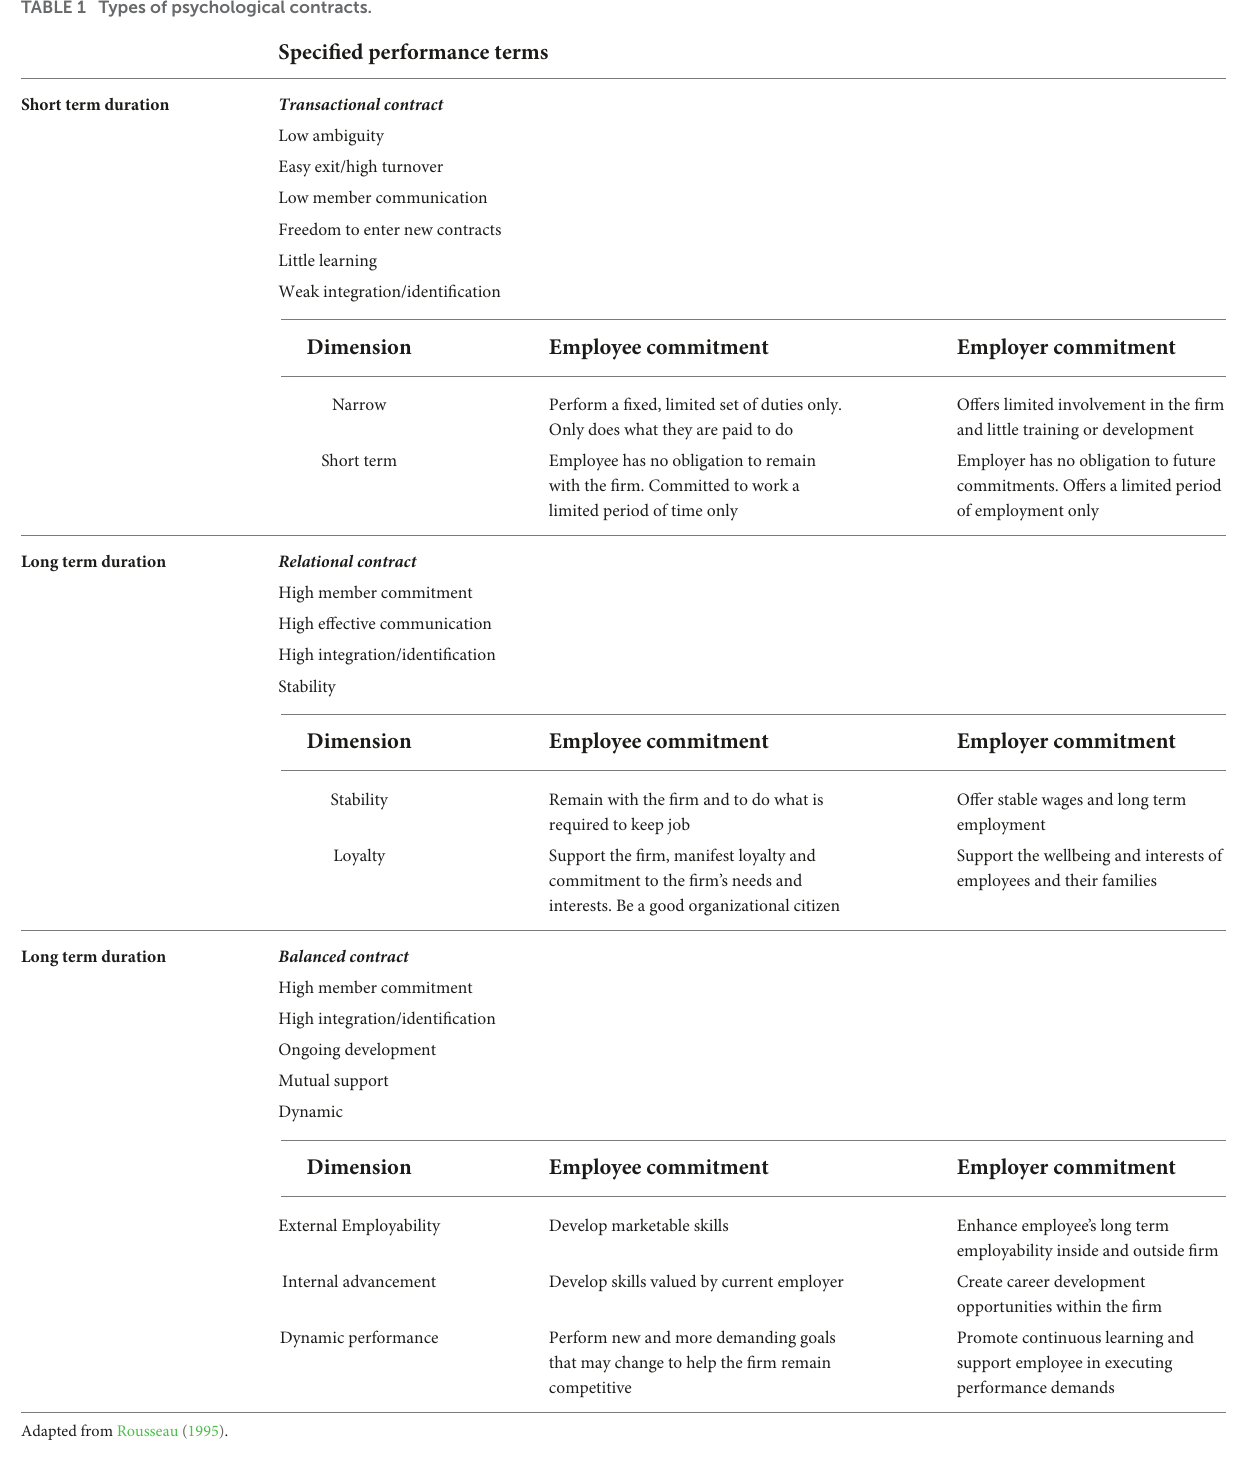
TABLE 1 Types of psychological